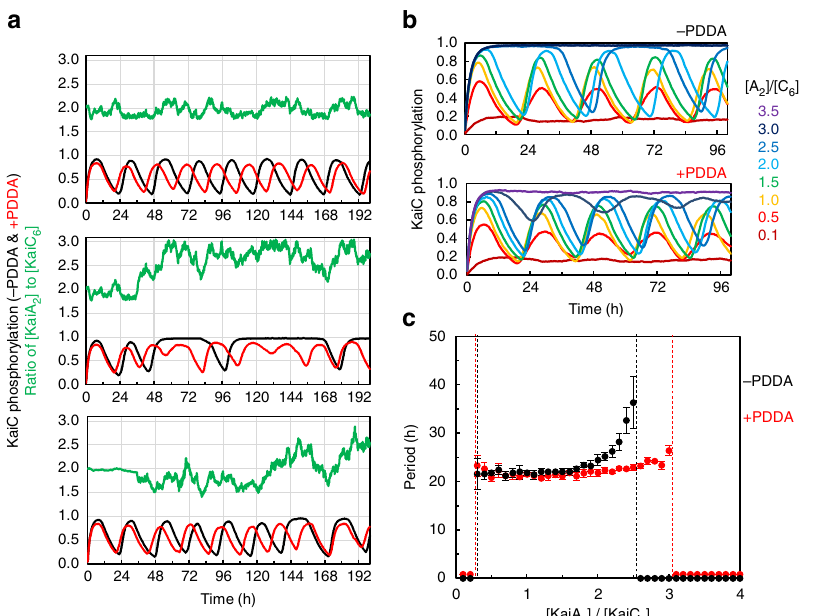
Fig. 6 PDDA enhances resilience to variations in Kai protein stoichiometry. a Simulated effect of PDDA on oscillatory consistency. Three examples of simulated randomly changing variation of KaiA concentration (green) on KaiC phosphorylation patterns + PDDA (red) versus − PDDA (black). Concentrations of KaiC and KaiB were held constant as [KaiA] was varied. b Representative KaiC phosphorylation as the ratio of concentrations of KaiA dimer to KaiC hexamer was varied from the beginning of the time course without subsequent changes in KaiA, KaiB, or KaiC concentrations. Simulations were performed in the absence of PDDA ( − PDDA, top) and with PDDA activated ( + PDDA, bottom). The scale of [KaiA]: [KaiC] is shown to the right ([A 2 ]/[C 6 ]). In the case of − PDDA, the top two simulations ([A 2 ]/[C 6 ] = 3.0 and 3.5) coincide. c Range of allowed oscillatory regime (dashed vertical lines) and estimated oscillatory period as KaiA dimer to KaiC hexamer ratio ([KaiA 2 ]/[KaiC 6 ]) was varied with ( + PDDA, red) or without PDDA ( − PDDA, black). Simulations performed as shown in b . Absence of oscillations is indicated as period = 0. Error bars are